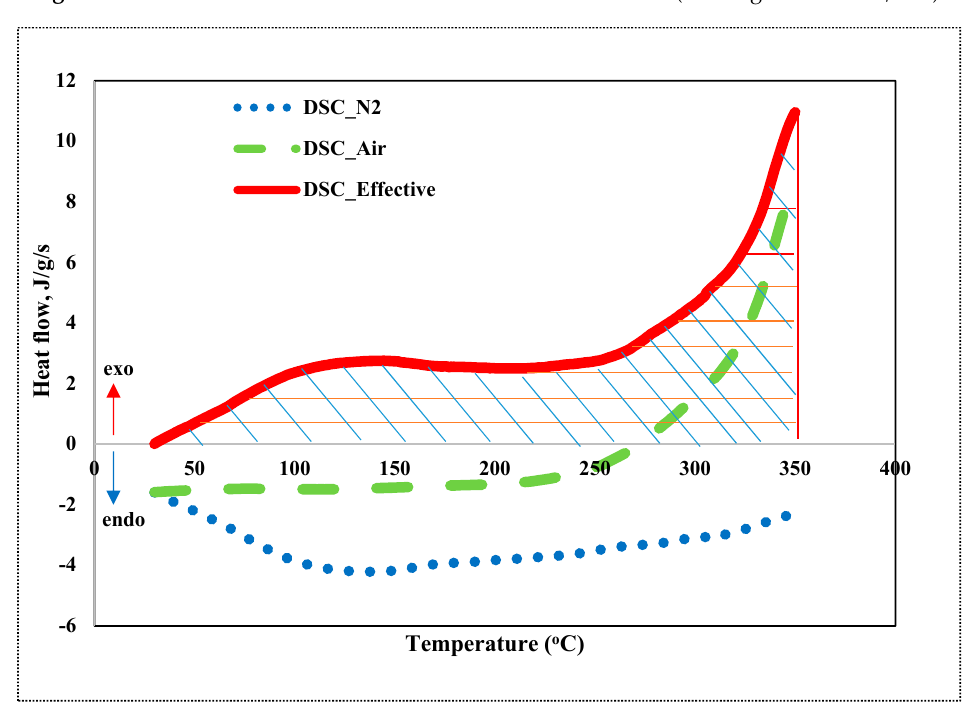
Figure 4. The DSC results of the mixture of oil and sand (Heating rate = 10 °C/min).